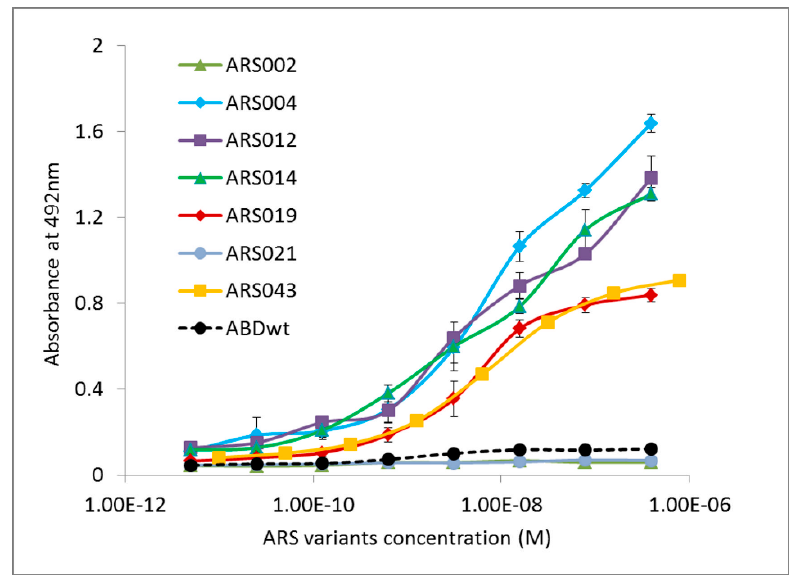
Figure 3. Binding of the selected representatives of ARS sequence families to the immobilized human IL-17RA-IgG chimera in ELISA. Purified binding proteins were produced in the form of in vivo biotinylated His 6 -ARS-TolA-AVI fusion proteins. Binding to IL-17RA-IgG was visualized by streptavidin-HRP conjugate. Each point represents the mean value ± standard deviation (SD).